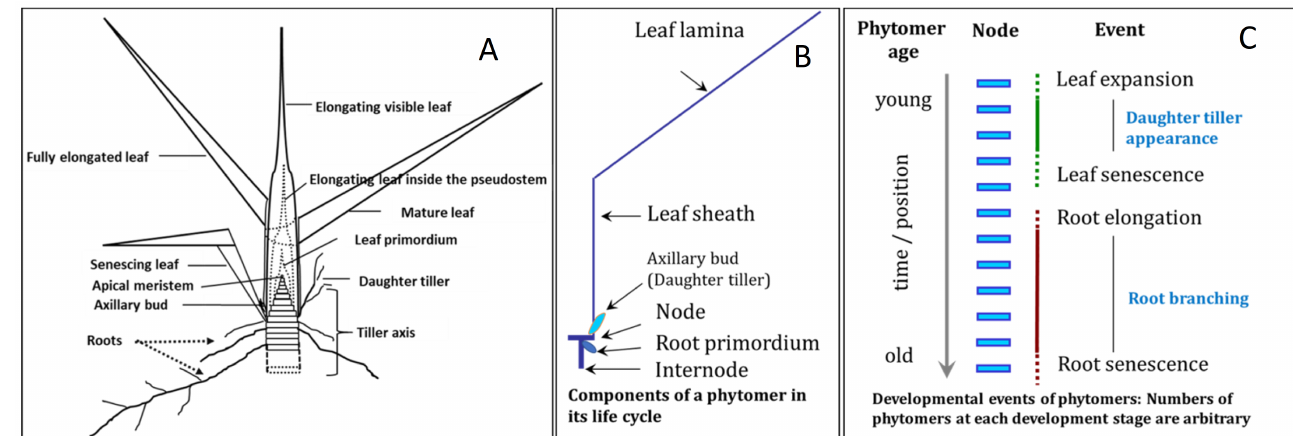
Figure 1. Developmental stages of phytomers in a vegetative grass tiller. In diagram ( A ) phytomers are represented as stacked discs within the tiller axis. Phytomer development progresses with phytomer age moving basipetally down the axis from the apical meristem, with the final event in the phytomer life cycle being root elongation. Leaf developmental stages have been drawn taking data from Yang et al. [3]. The diagram has been drawn following Matthew et al. [7]. Diagram ( B ) represents the morphological components of a typical vegetative-tiller phytomer. Diagram ( C ) illustrates the spatial separation on the tiller axis and temporal separation for a particular phytomer, of leaf and root developmental